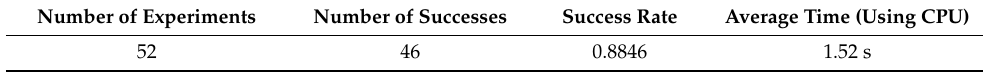
Table 3. Results of close-distance fruit-bearing stem location algorithm